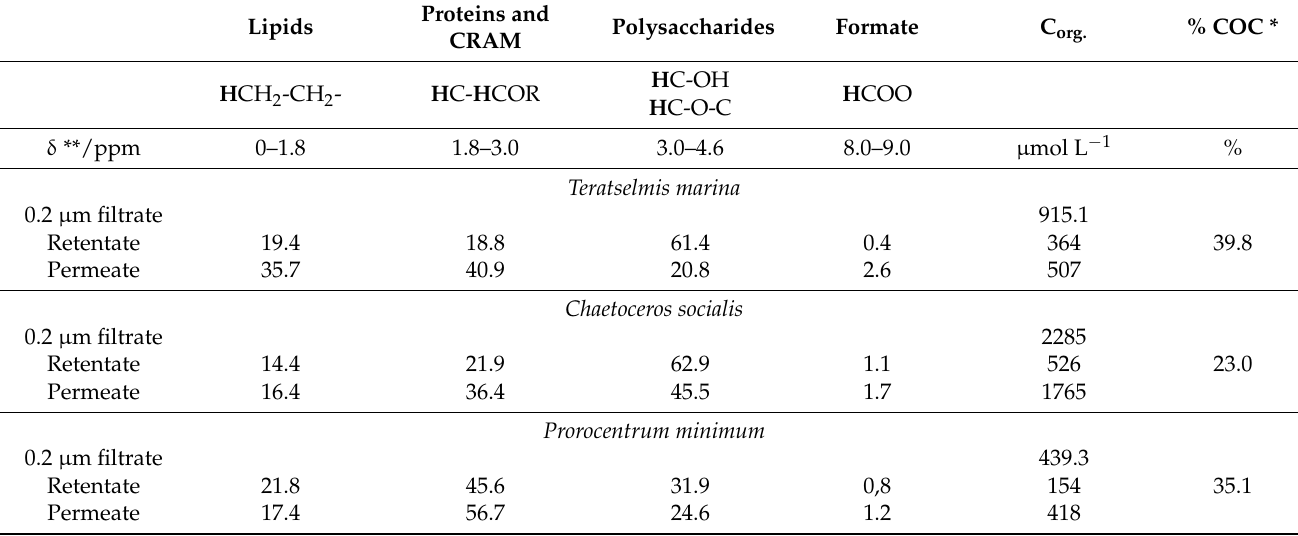
Table 1. Distribution of the integrated main groups of proton resonances (lipids, proteins and CRAM, polysaccharides and formate) in 1 H MNR spectra ( δ /ppm), concentrations of C org. ( µ mol L − 1 ) in retentates and permeates and % COC from exudates of cultured phytoplankters. Protons that resonated in certain chemical shift range of integrated main groups are in bold (second